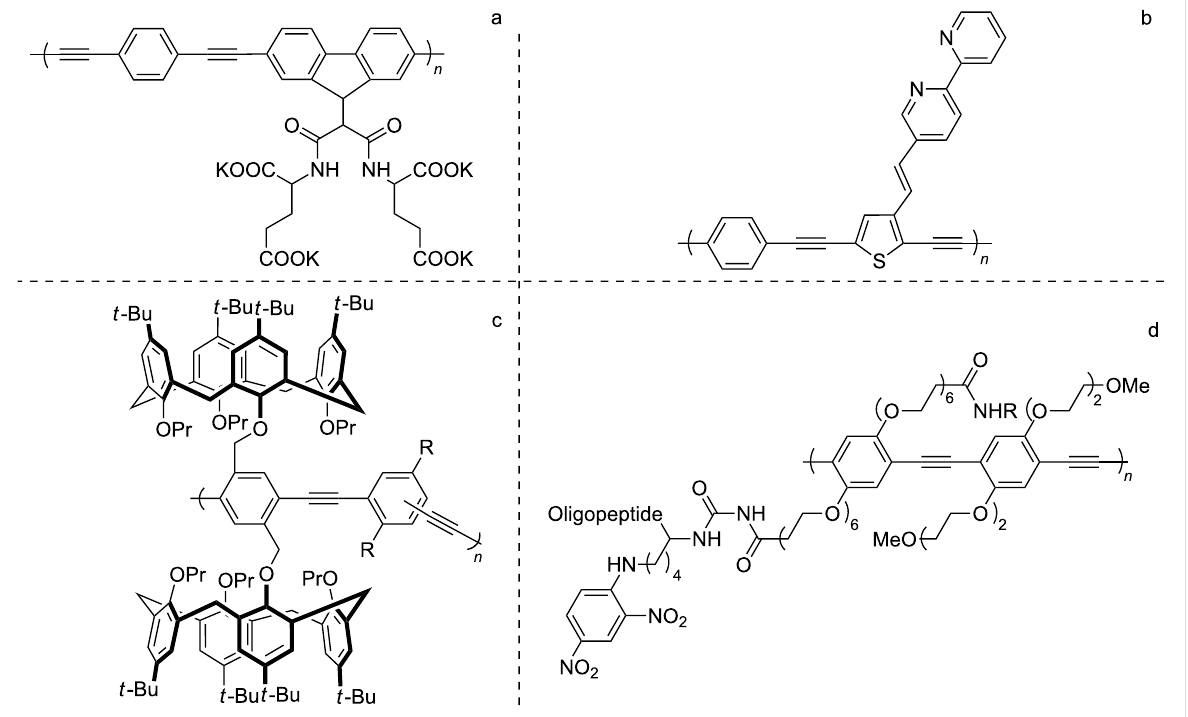
Figure 1: Recent examples of PAEs and their application for the detection of Hg 2+ (a) [11], Ni 2+ (b) [12], explosives (c) [13] and trypsin (d) [14].